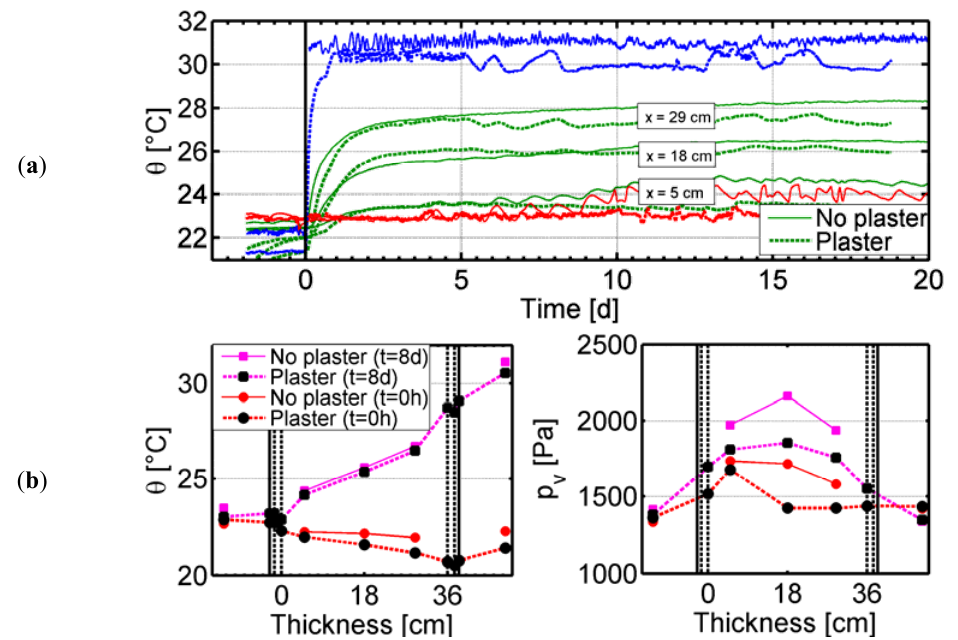
Figure 13. Comparison of experimental results for uncoated (solid lines) and coated (dashed lines) wall subjected to temperature and relative humidity gradient. Time response in θ is shown on the top graph ( a ); and spatial response in θ and p is shown on the bottom graph ( b